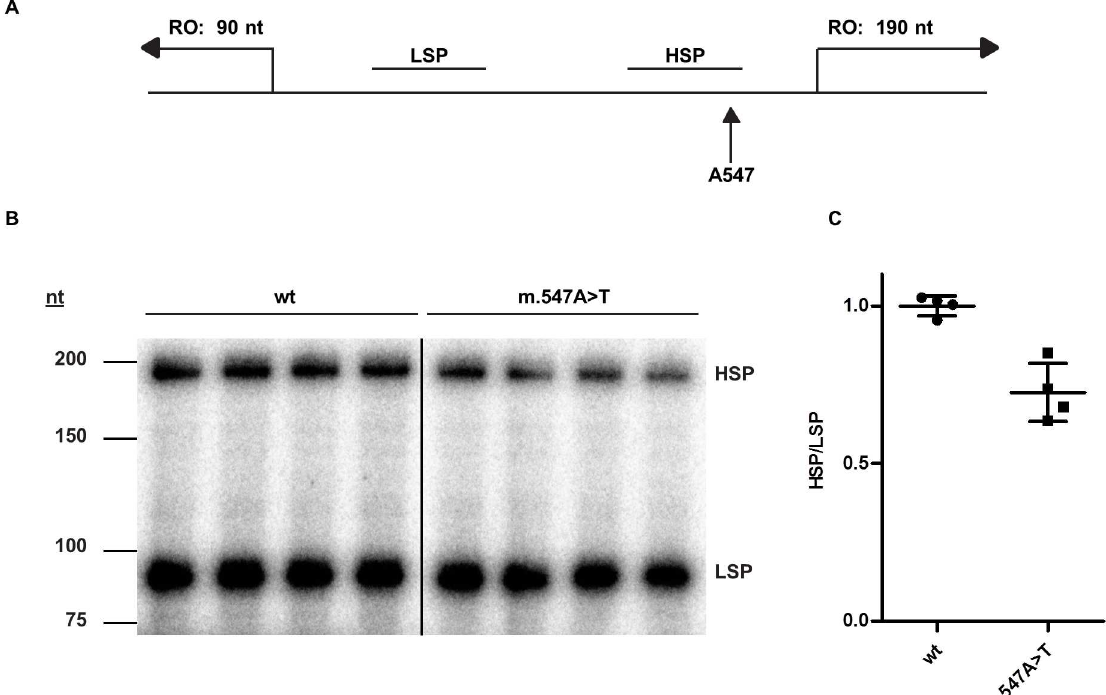
Fig 5. m.547A > T impairs mitochondrial heavy strand promoter activity. (A) In vitro transcriptionwith purifiedmitochondrial transcription factors and a dual promoter construct containingthe heavy (HSP) and light strand promoter (LSP) was used to assess the effect of the m.547A > Tsubstitution. The linear template results in run off (RO) transcripts of 190 nucleotides (nt) from the HSP and 90 nt from the LSP. (B) Metabolically labelledtranscripts from wild type (wt) and m.547A > T variant promoter (A547T) were analysedby autoradiography. (C) Analysis of relative band intensities of (B) shows a significantreduction of HSP activity in the presence of the m.547A > T substitution(p = 0.0014). The experiment was performed three times yieldingthe same